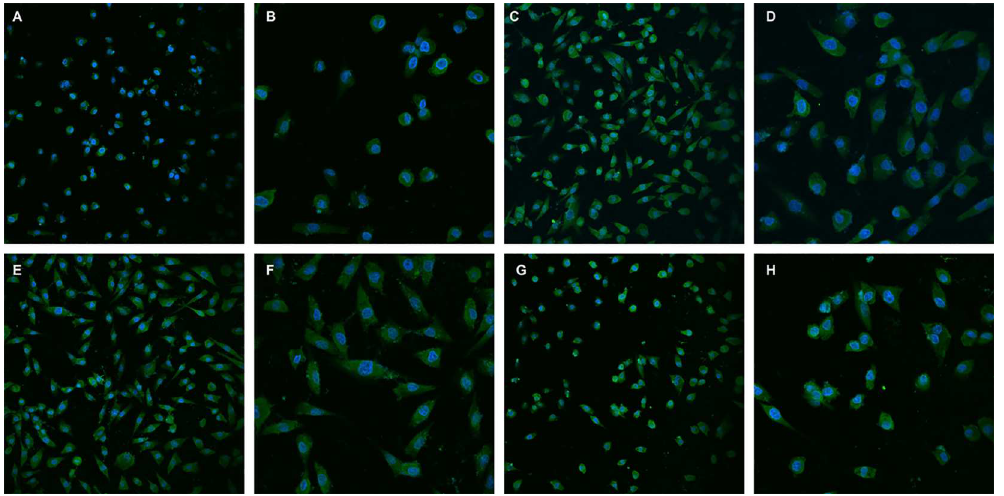
Fig 13. Skin cells which were treated with 0.2 g/L MT, 10 − 5 g/L FGF5, or 10 − 6 g/L IGF-I respectively for 72 h were observed under bright field of the laser scanning confocal microscope. Fig 13A. Skin cells which were treated without MT, FGF5 or IGF-I (25 × ). Fig 13B. Skin cells which were treated without MT, FGF5 or IGF-I (100 × ). Fig 13C. Skin cells which were treated with 0.2 g/L MT (25 × ). Fig 13D. Skin cells which were treated with 0.2 g/L MT (100 × ).Fig 13E. Skin cells which were treated with 10 − 5 g/L FGF5 (25 × ). Fig 13F. Skin cells which were treated with 10 − 5 g/L FGF5 (100 × ). Fig 13G. Skin cells which were treated with 10 − 6 g/L IGF-I (25 × ). Fig 13H. Skin cells which were treated with 10 − 6 g/L IGF-I (100 ×